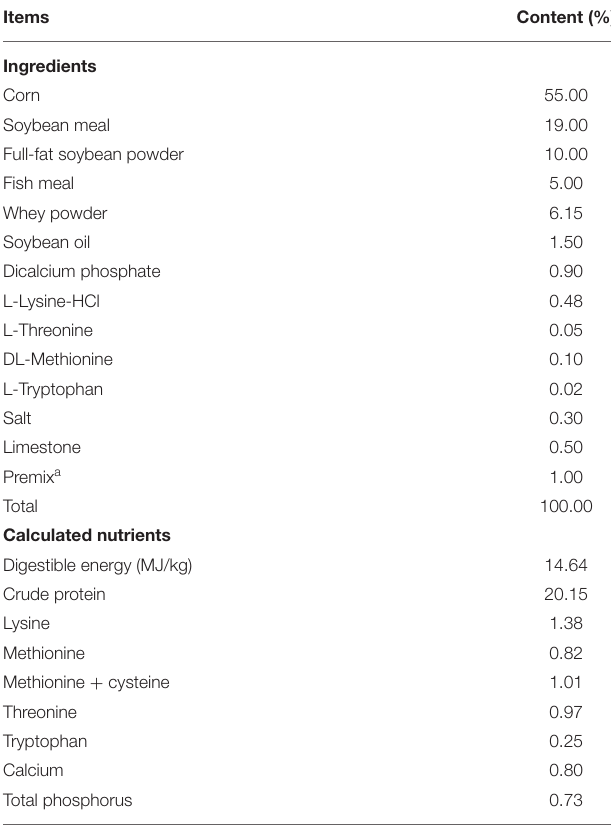
TABLE 1 | Ingredients and chemical composition of experimental diets (as-fed